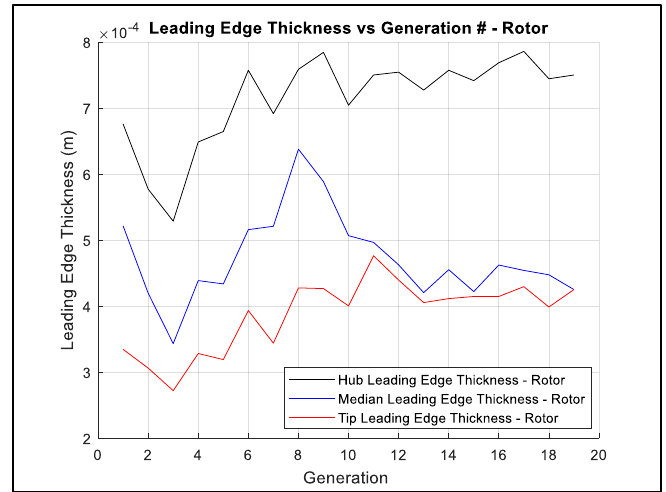
Figure 17. Elite member rotor leading edge thickness against generation number.